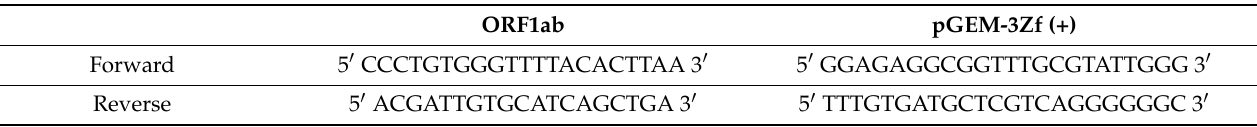
Table 1. Primer sequences in PCR verification experiment. ORF1ab pGEM-3Zf ( + ) Forward 5 ′ CCCTGTGGGTTTTACACTTAA 3 ′ Reverse 5 ′ ACGATTGTGCATCAGCTGA 3 ′